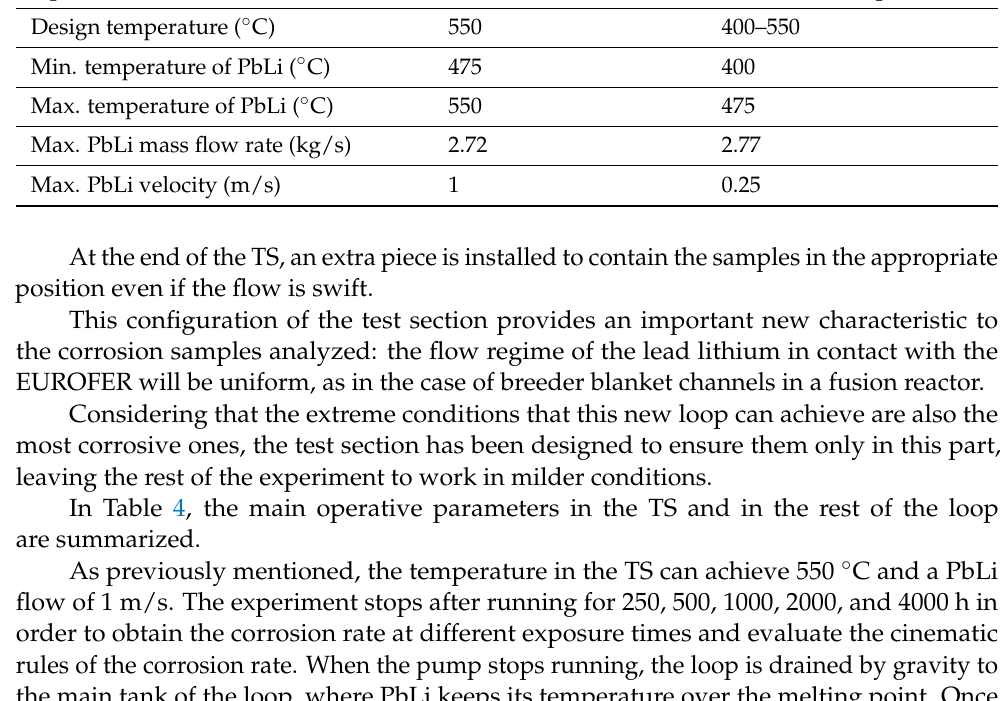
Table 4. Comparison of the main operative parameters in the TS and the rest of the loop. Operative